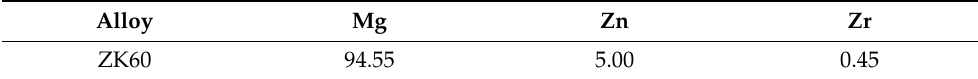
Table 1. Alloy composition in weight percentage.